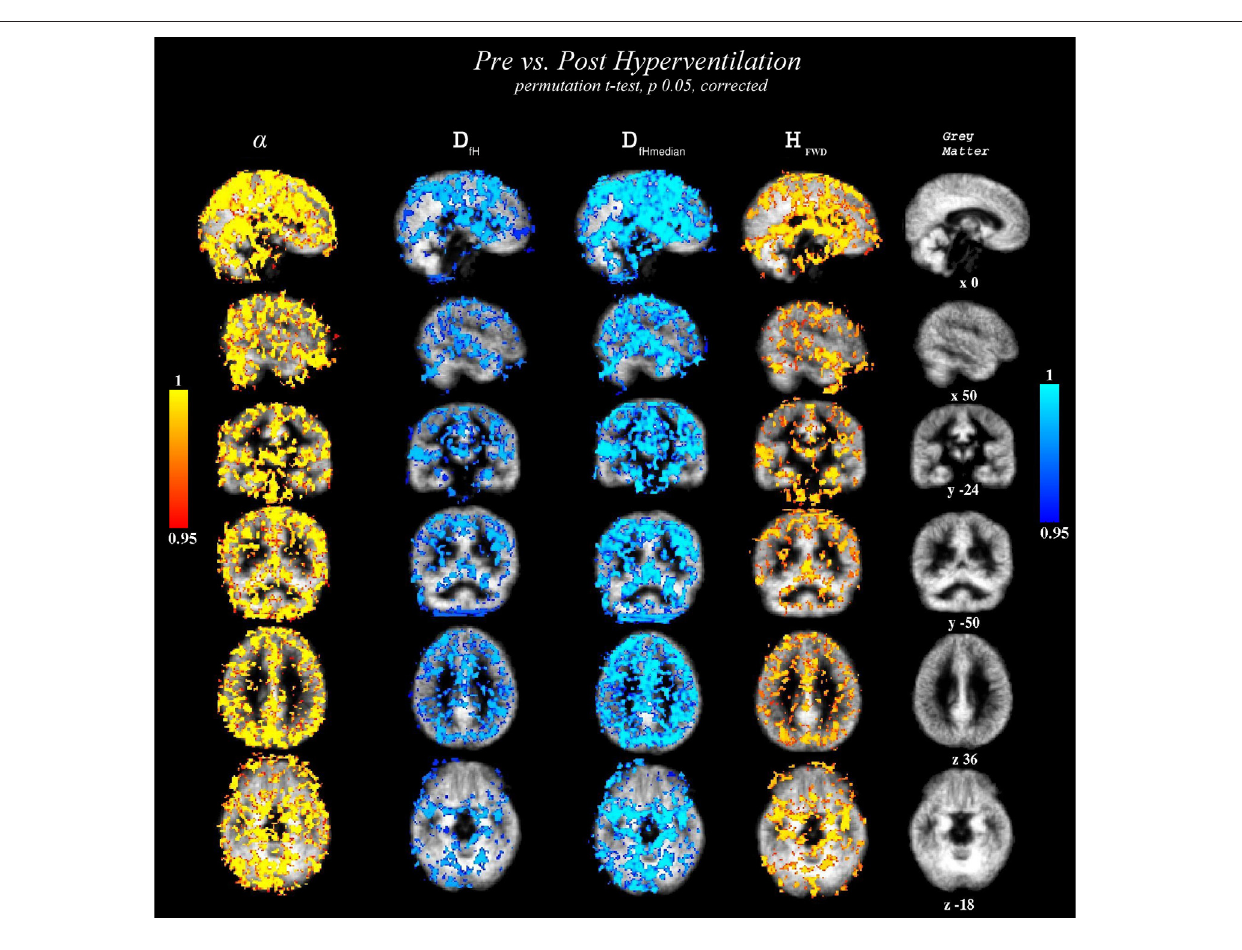
the MNI coordinates in the same locations as in Figure 3 . From left to right: α , D , D and H . Cold-blue colours = decrease, and fH fHmedian FWD warm red-yellow colours = increase in variable between Pre and Post , respectively.